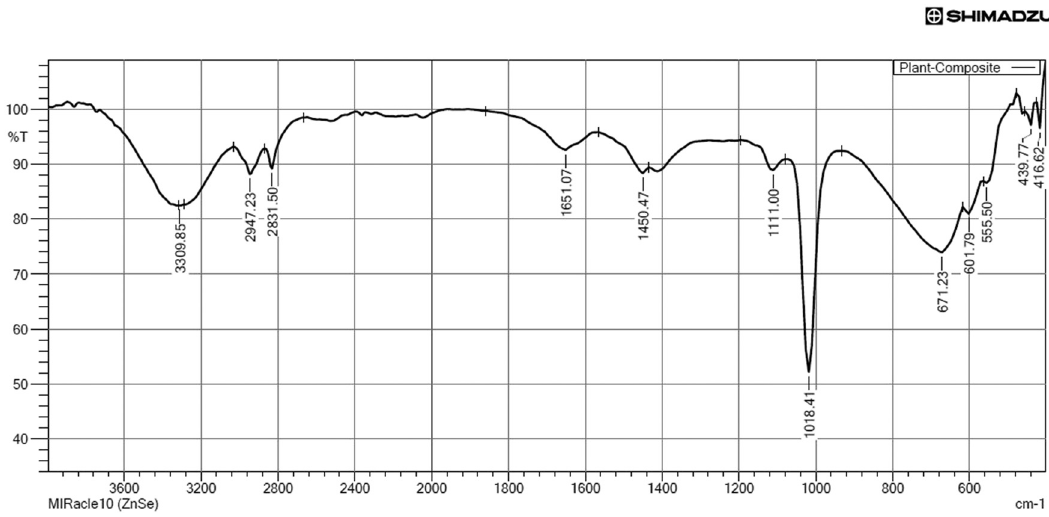
Figure 3: FT - IR spectrum of the plant composites.